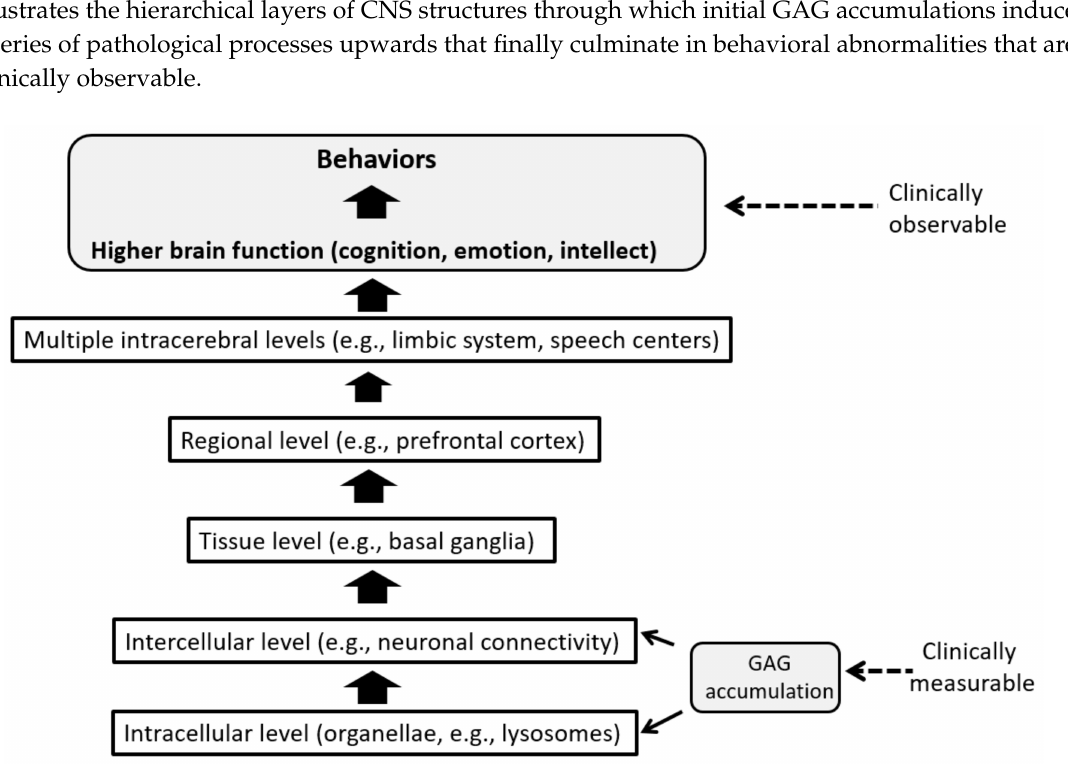
Figure 3. Hierarchical progression of neurodegeneration and CNS manifestations in